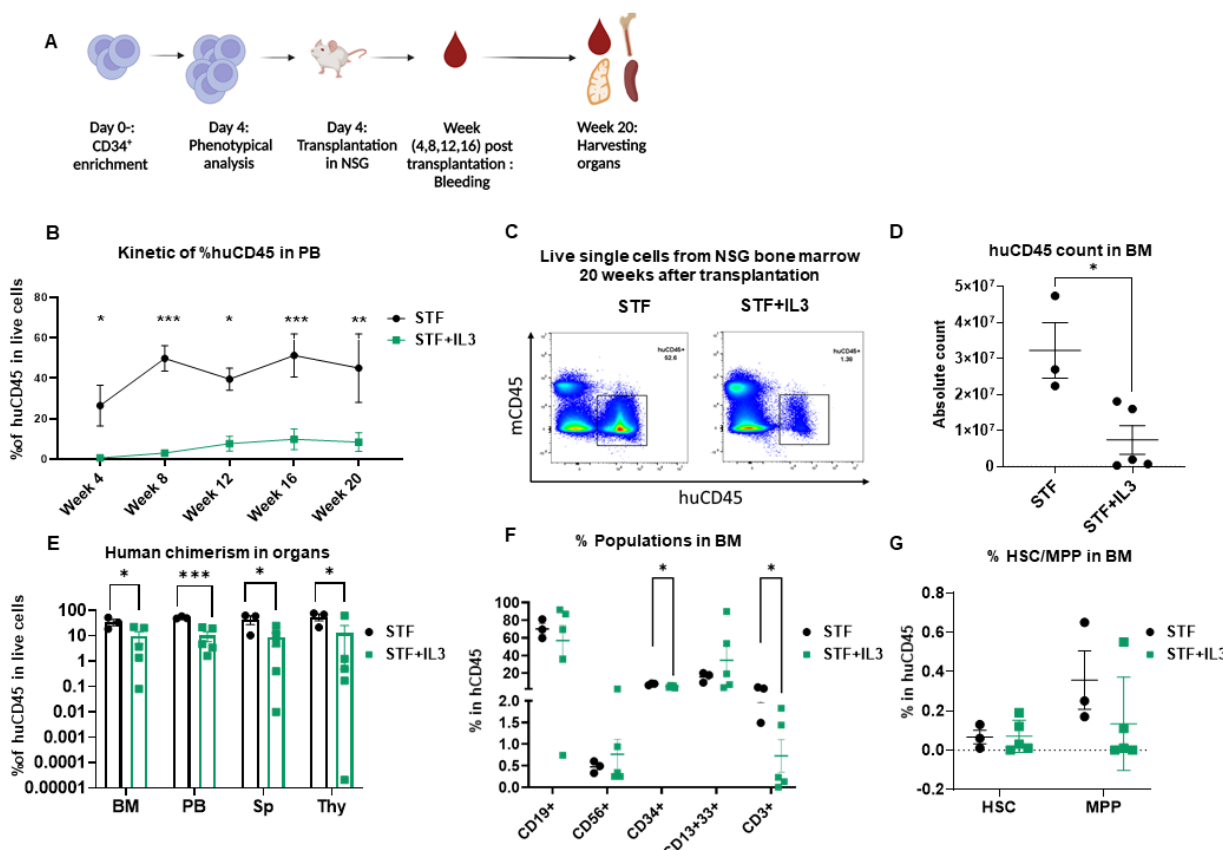
Figure 2. IL3 has an adverse effect on human engraftment in NSG mice: ( A ) Schematic experimental design. ( B ) Human CD45 engraftment in PB over time ( n = 3–5; * p < 0.05, ** p < 0.01 and *** p < 0.001, 2-way Anova test with multiple comparison). ( C ) Representative flow cytometry plots of bone marrow cells harvested from mice that received expanded cells. ( D ) Absolute count of human CD45 + cells in bone marrow after 20 weeks of transplantation. ( n = 3–5; * p < 0.05 unpaired t -test). ( E ) Percentage of human CD45 cell engraftment in different organs (BM = Bone marrow, PB = Peripheral Blood, Sp = Spleen, Thy = Thymus) in primary recipient NSG mice 20 weeks after transplantation ( n =